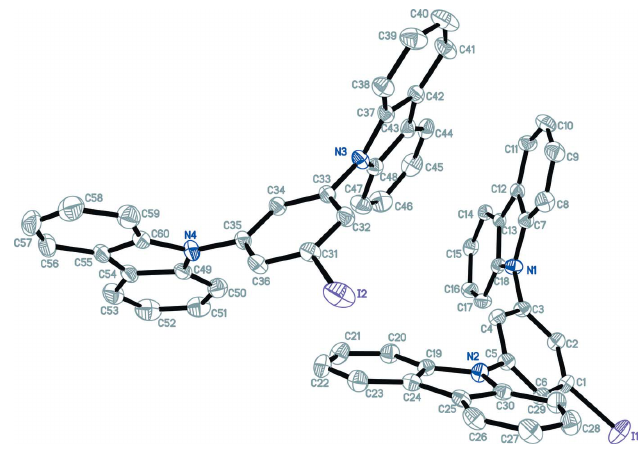
Figure 1 The molecular structure of the title compound showing 30% displace- ment ellipsoids with H atoms omitted for clarity.